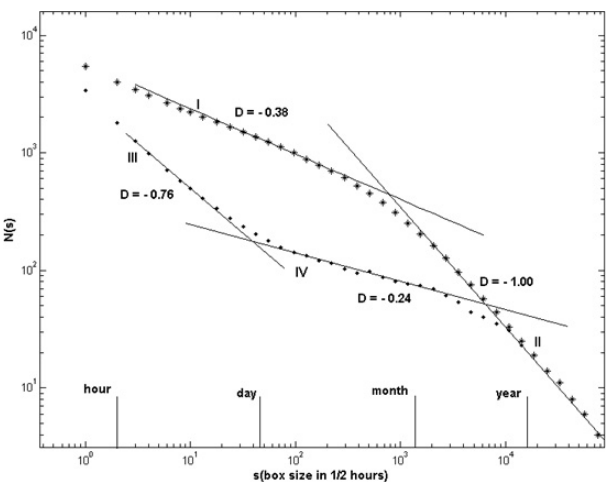
Fig. 8. Box-counting log–log plots and slopes, D , for the rainfall (asterisks) and dust event (dots) data series at Gran Canaria airport, and METARs for the period 1989–2010.